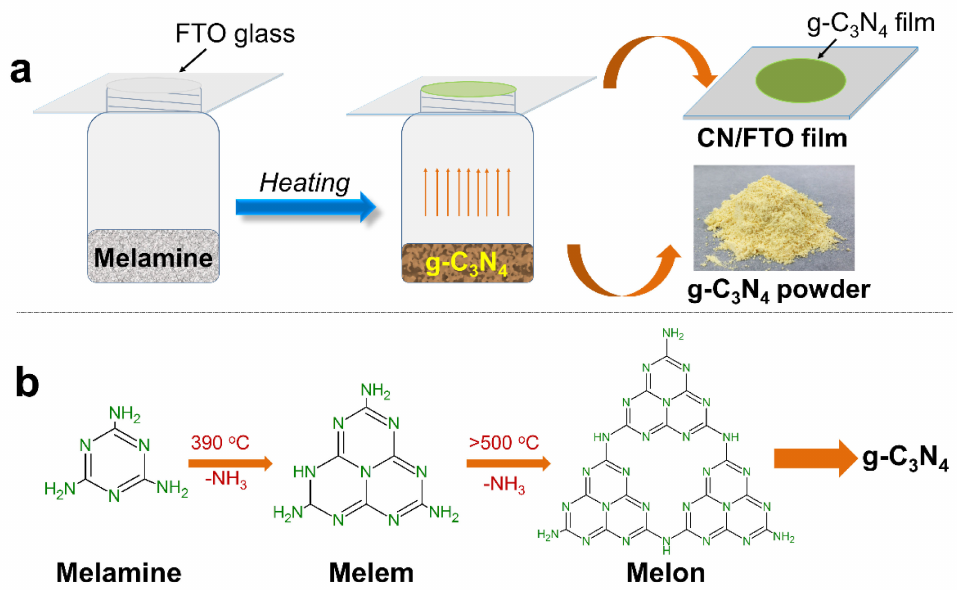
Figure 1. Schematic illustration of ( a ) the experimental procedure for preparing thin CN/FTO film and g-C 3 N 4 powder samples via heating melamine precursor, and ( b ) thermal polymerization of melamine to g-C 3 N 4 .